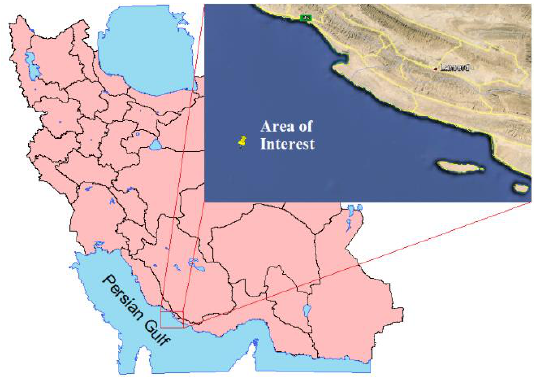
Figure 1. Persian Gulf location and area of interest